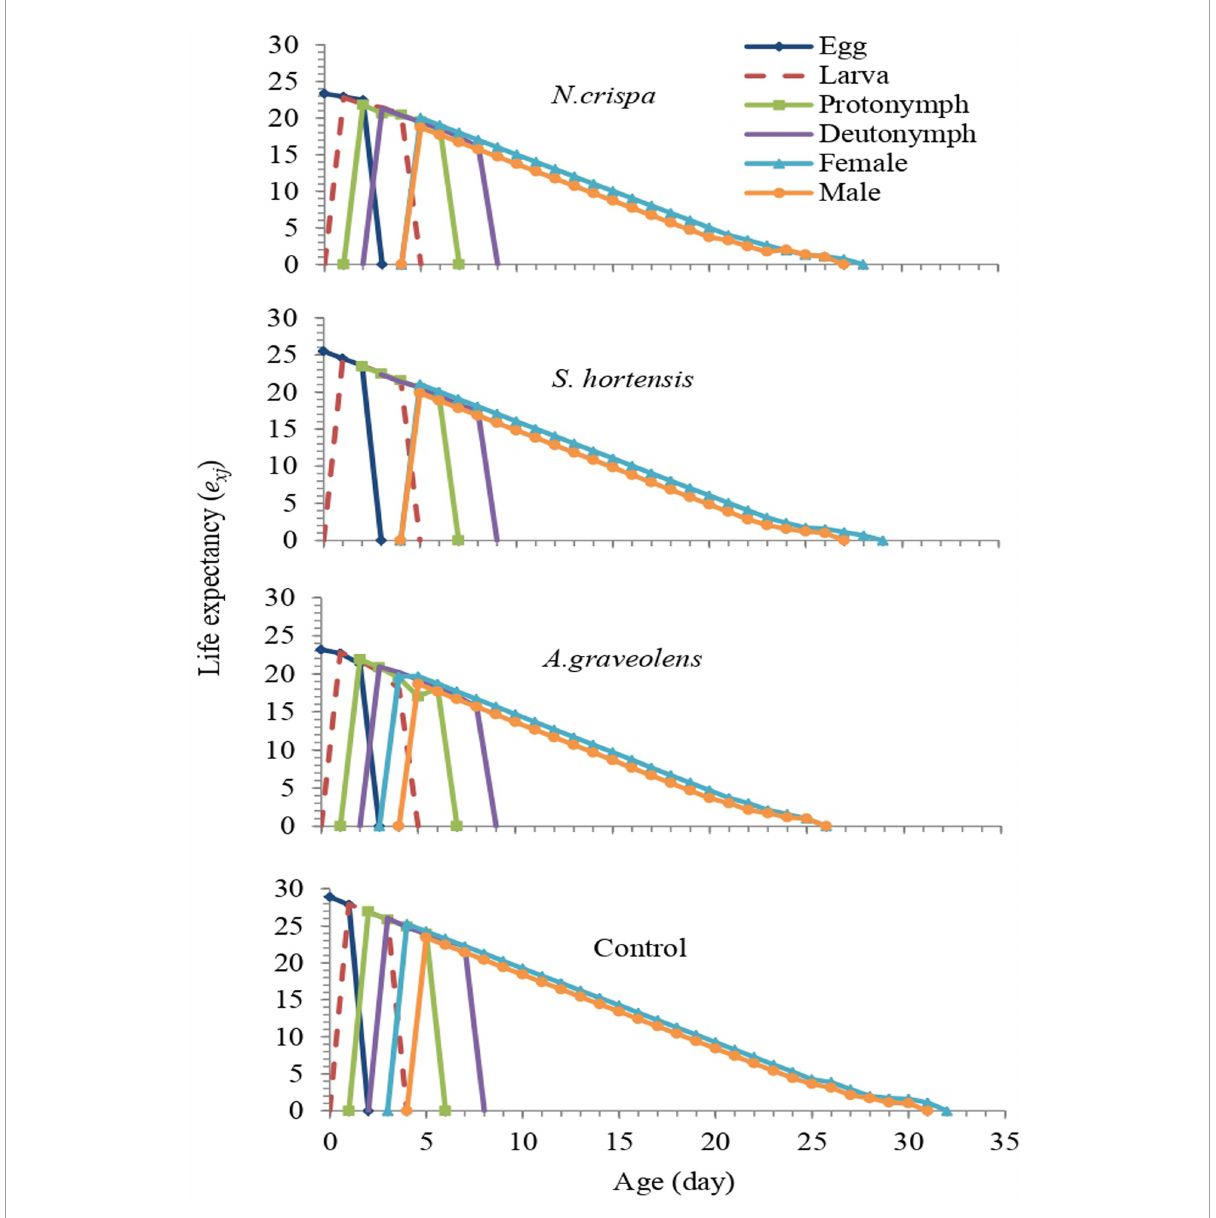
FIGURE6 Age-stage life expectancy ( e xj ) of A. swirskii females from control and treatments of N. crispa , S. hortensis , and A. graveolens